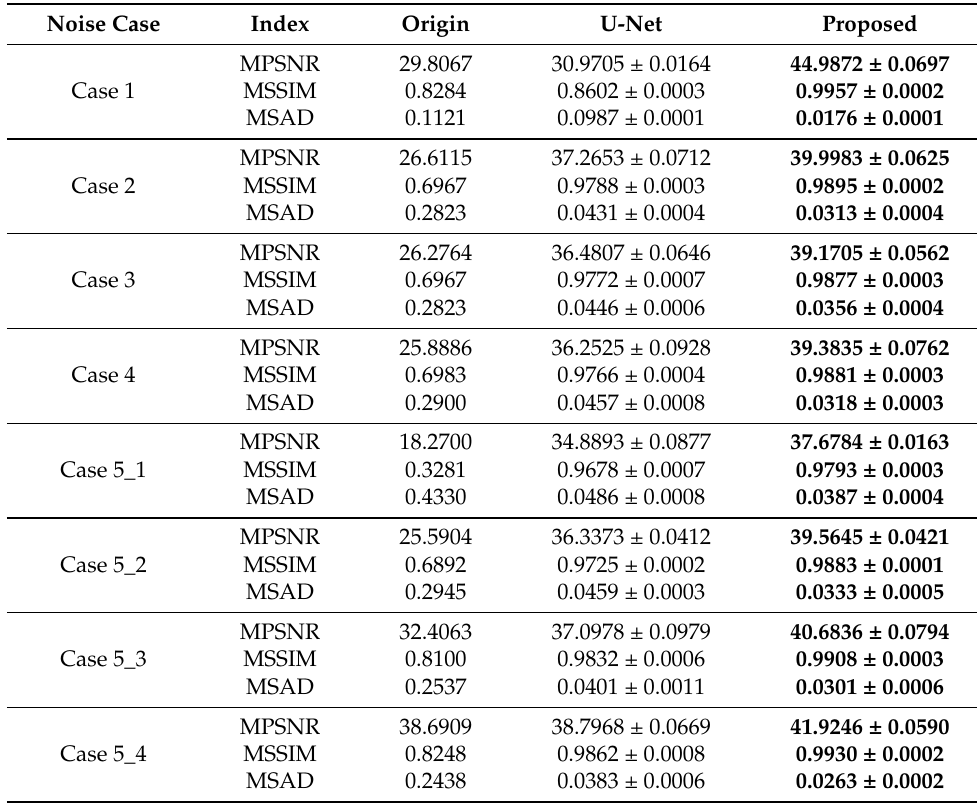
Table 2. Quantitative evaluation of the ablation experiment on the SFD dataset: architecture.